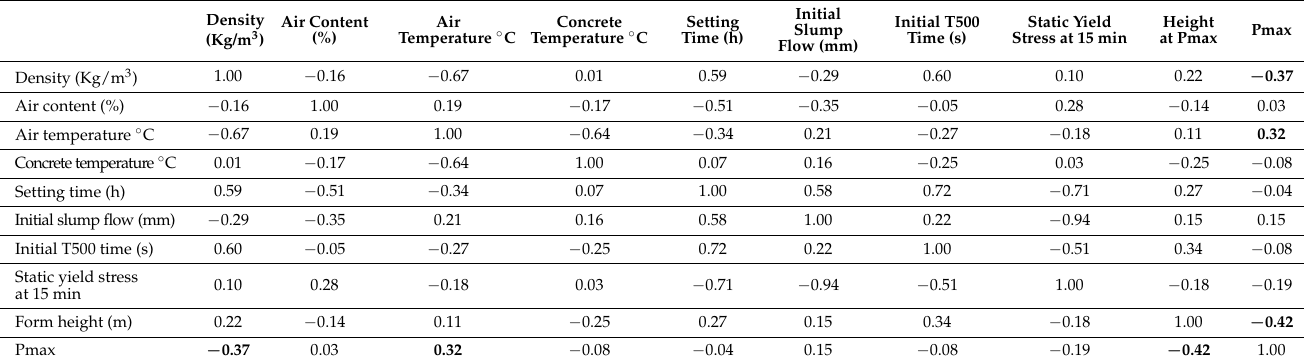
Table 3. Correlation between input variables and form